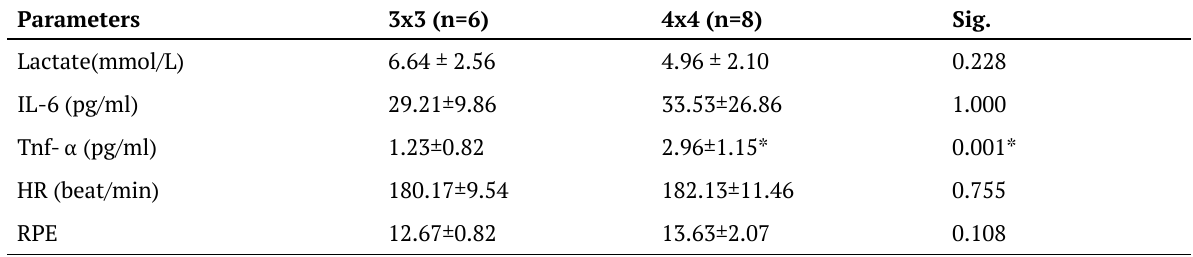
Table 4. Comparison of post training La, IL-6, Tnf-